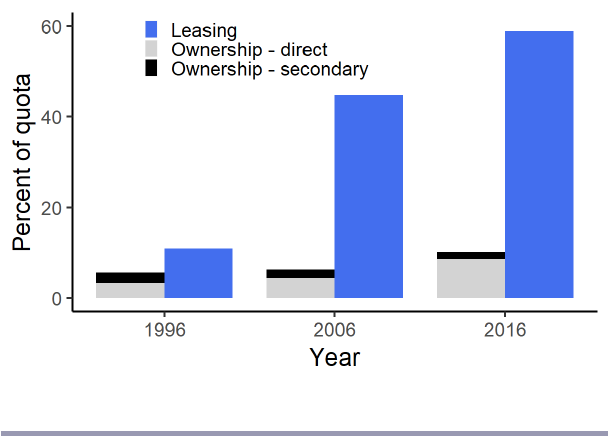
Fig. 2 . Processor quota ownership expressed as a percentage